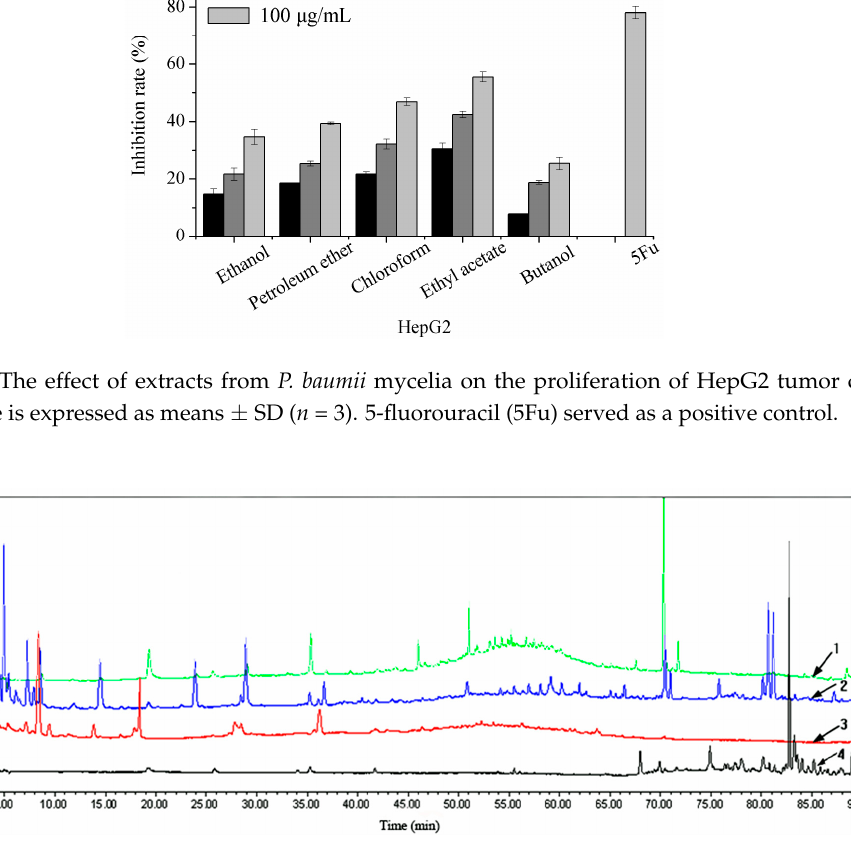
Figure 2. HPLC chromatograms ( λ = 254 nm) of the fractions from P. baumii mycelium. 1: chloroform extract; 2: ethyl acetate extract; 3: butane extract; 4: petroleum ether extract.